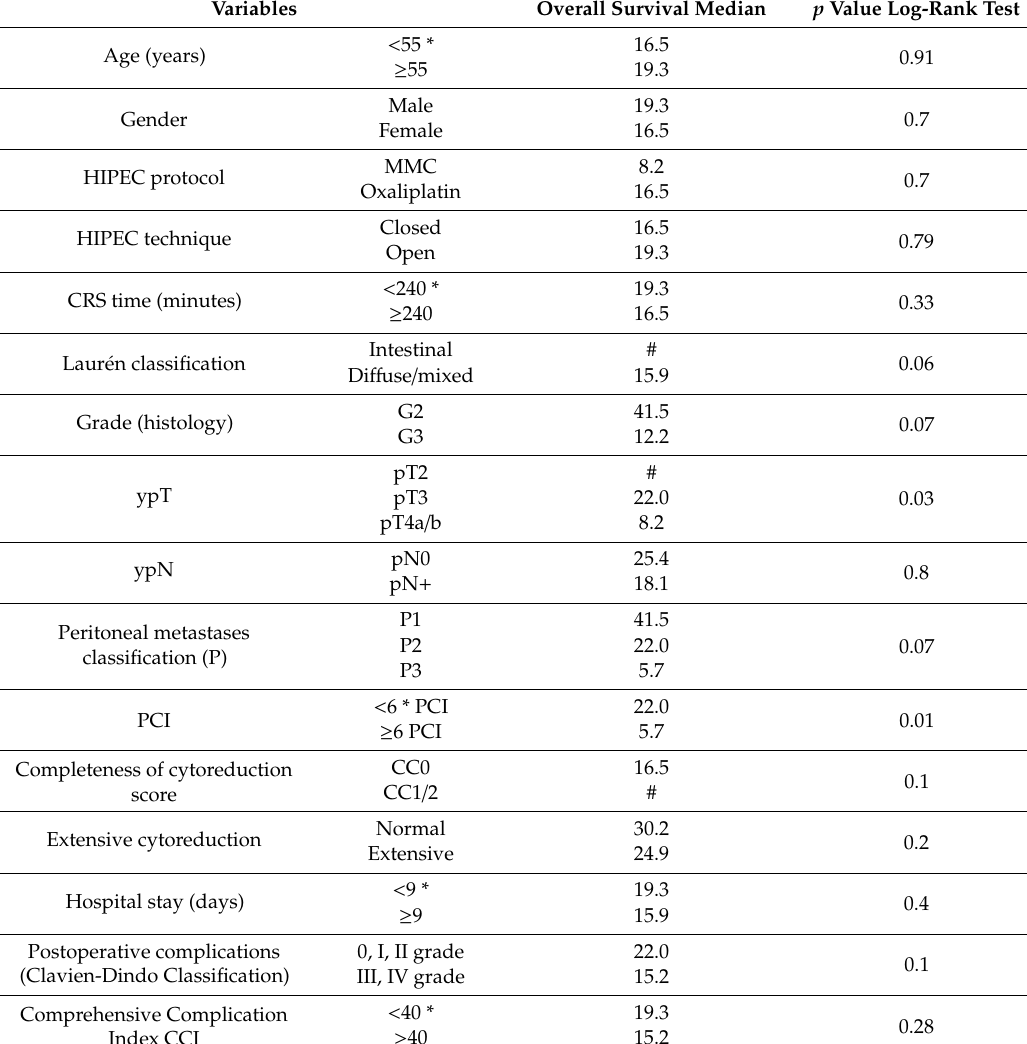
Table 4. Univariate analysis of predictors for overall